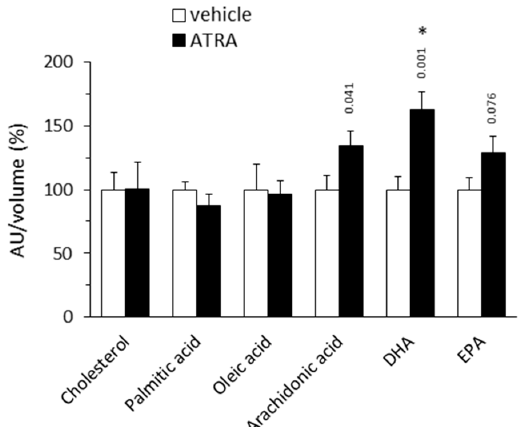
Figure 3. Relative plasma levels of the indicated lipids in NMRI mice treated with all-trans retinoic acid (ATRA; 50 mg / kg body weight, subcutaneous injection) or the vehicle (olive oil) during 4 days. Metabolite peak area (as arbitrary units, AU) was normalized by the volume of (plasma used in LC-MS / MS. Data are expressed as percentage with respect to the normalized value in the control group, which was set to 100%, and are the mean ± SEM of 11 animals per group. * Indicates significant di ff erence between the ATRA and the control group after Benjamini–Hochberg correction (observed p values in two-tailed Student’s t test are indicated when p < 0.1). DHA, docosahexaenoic acid; EPA, eicosapentaenoic